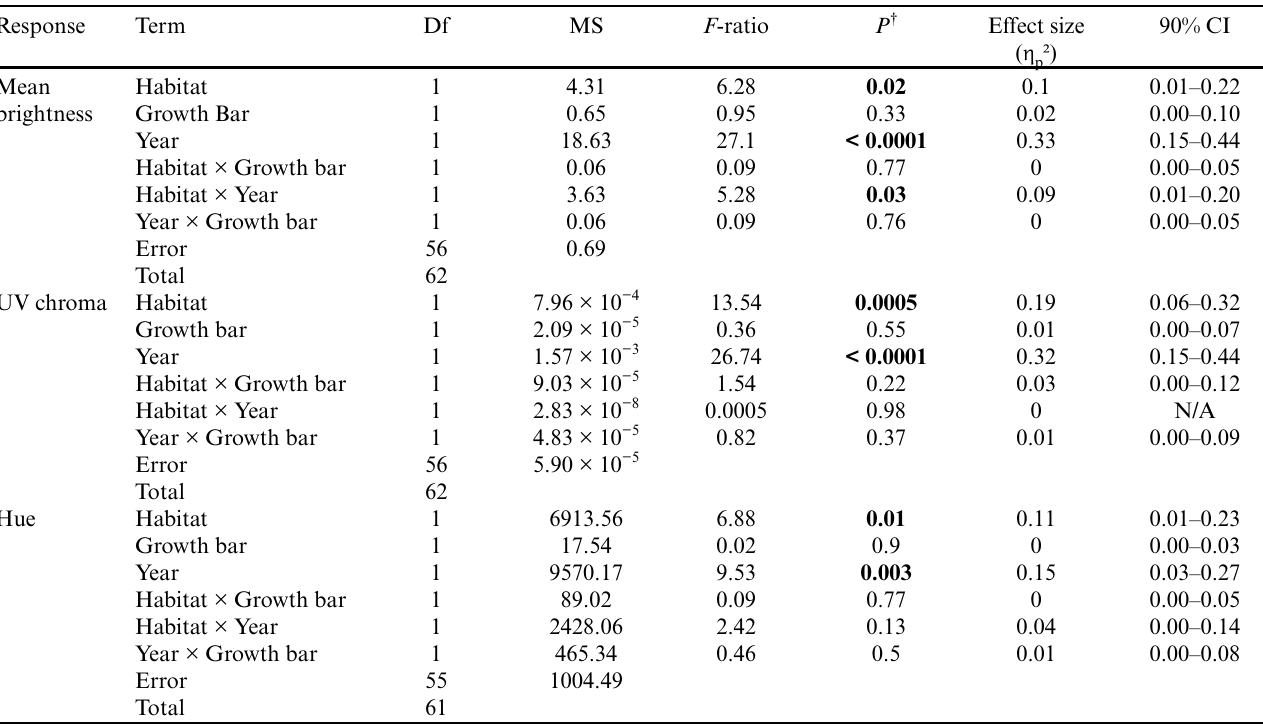
† Boldface font indicates statistically significant